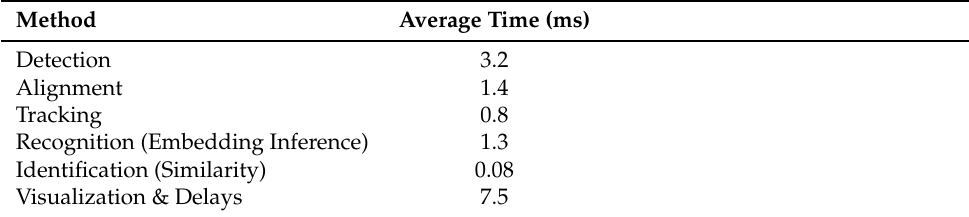
Table 3. Average execution time of individual methods used in the proposed framework.